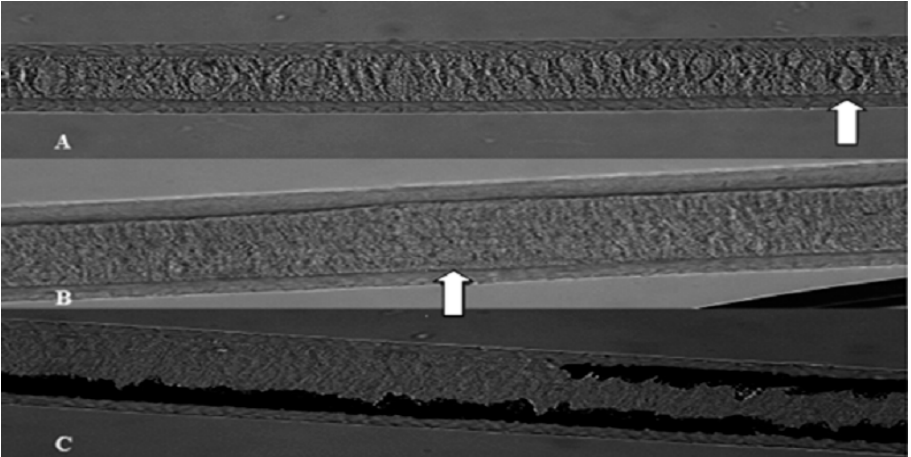
Figure 2. ( A ) Medulla pattern in the hair shield of Bovino Pantaneiro breed (continuous, multiseriate, anastomosed, trabecular with fimbriated margins and a marked presence of vacuoles); ( B ) medulla pattern in the hair shield of Caracu and Curraleiro Pé-Duro breeds (continuous, multiseriate, anastomosed, trabecular with fimbriated margins and a moderate presence of vacuoles); ( C ) medulla pattern in Nelore zebu breed (continuous, multiseriate, anastomosed, trabecular with fimbriated margins and no vacuoles).